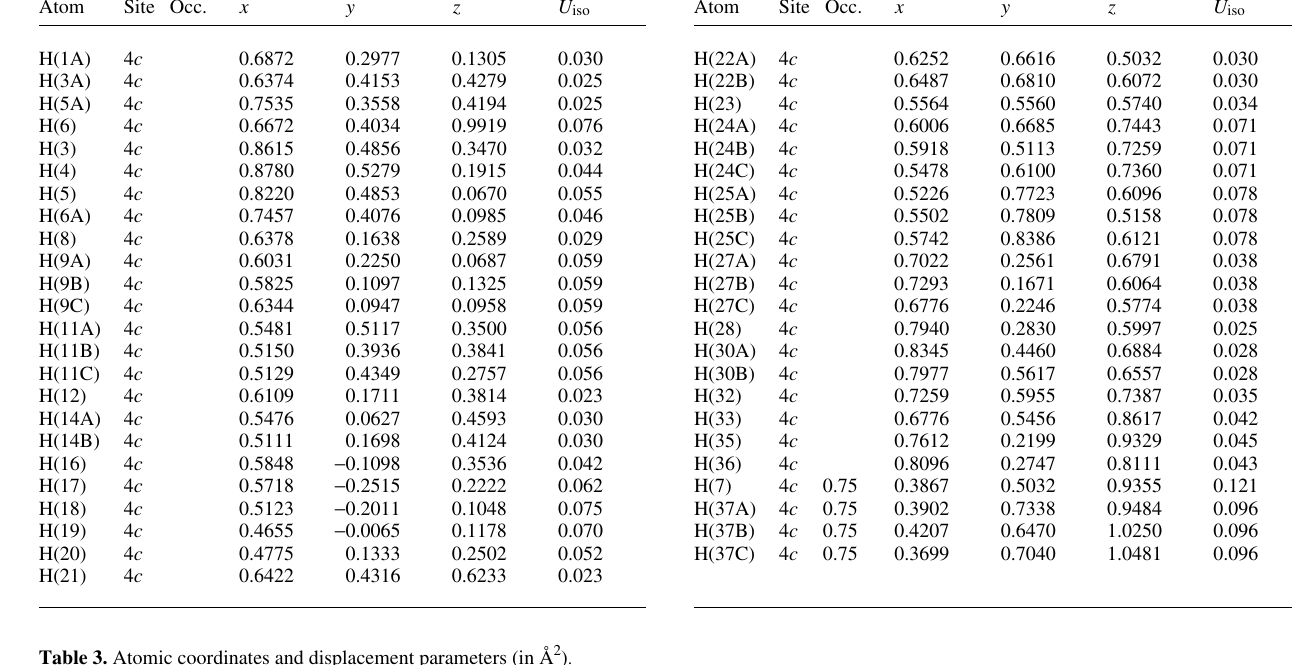
Table 2. Atomic coordinates and displacement parameters (in Å 2 ) . Atom Site